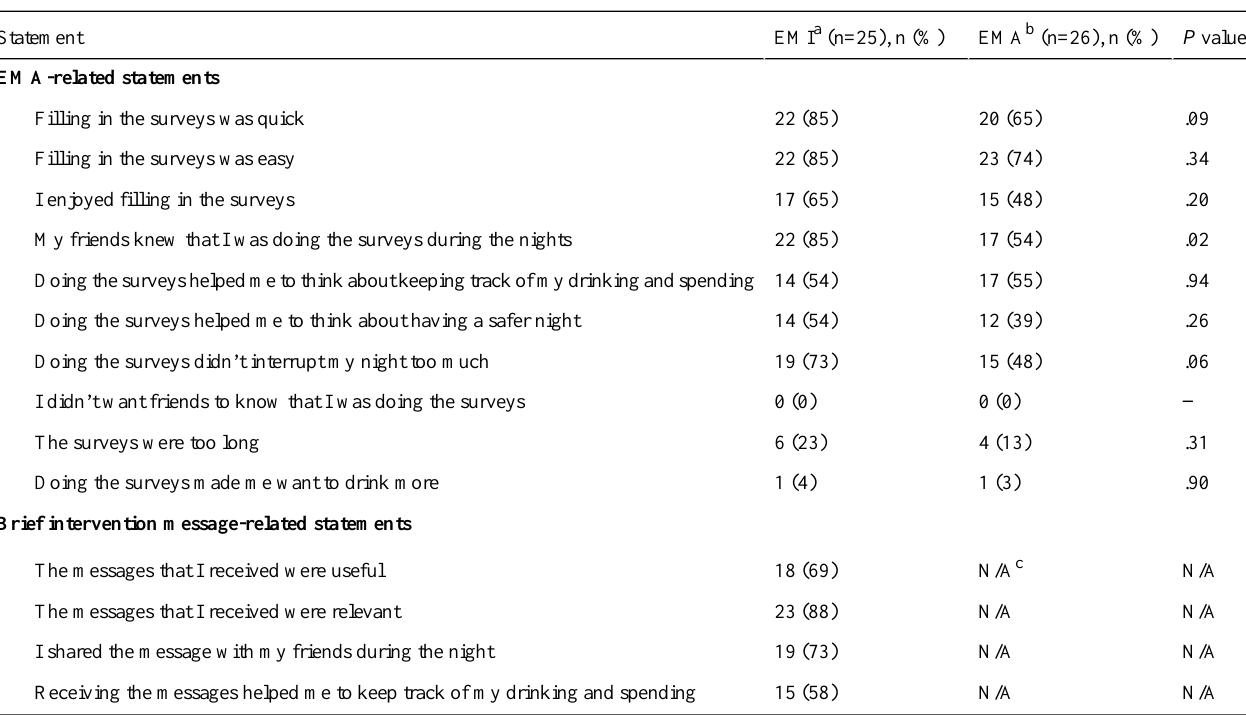
Table 4. Participant agreement with acceptability-related statements by study group: counts (%) and P values from chi-square inferential tests. Agreement was taken as either “agreeing” or “strongly agreeing” with a respective statement.